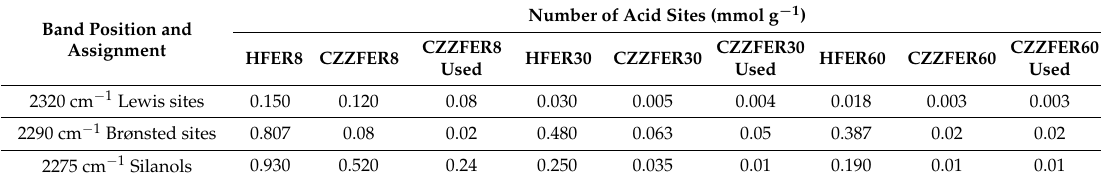
Table 1. Concentration of accessible acid sites in HFER and CZZFER